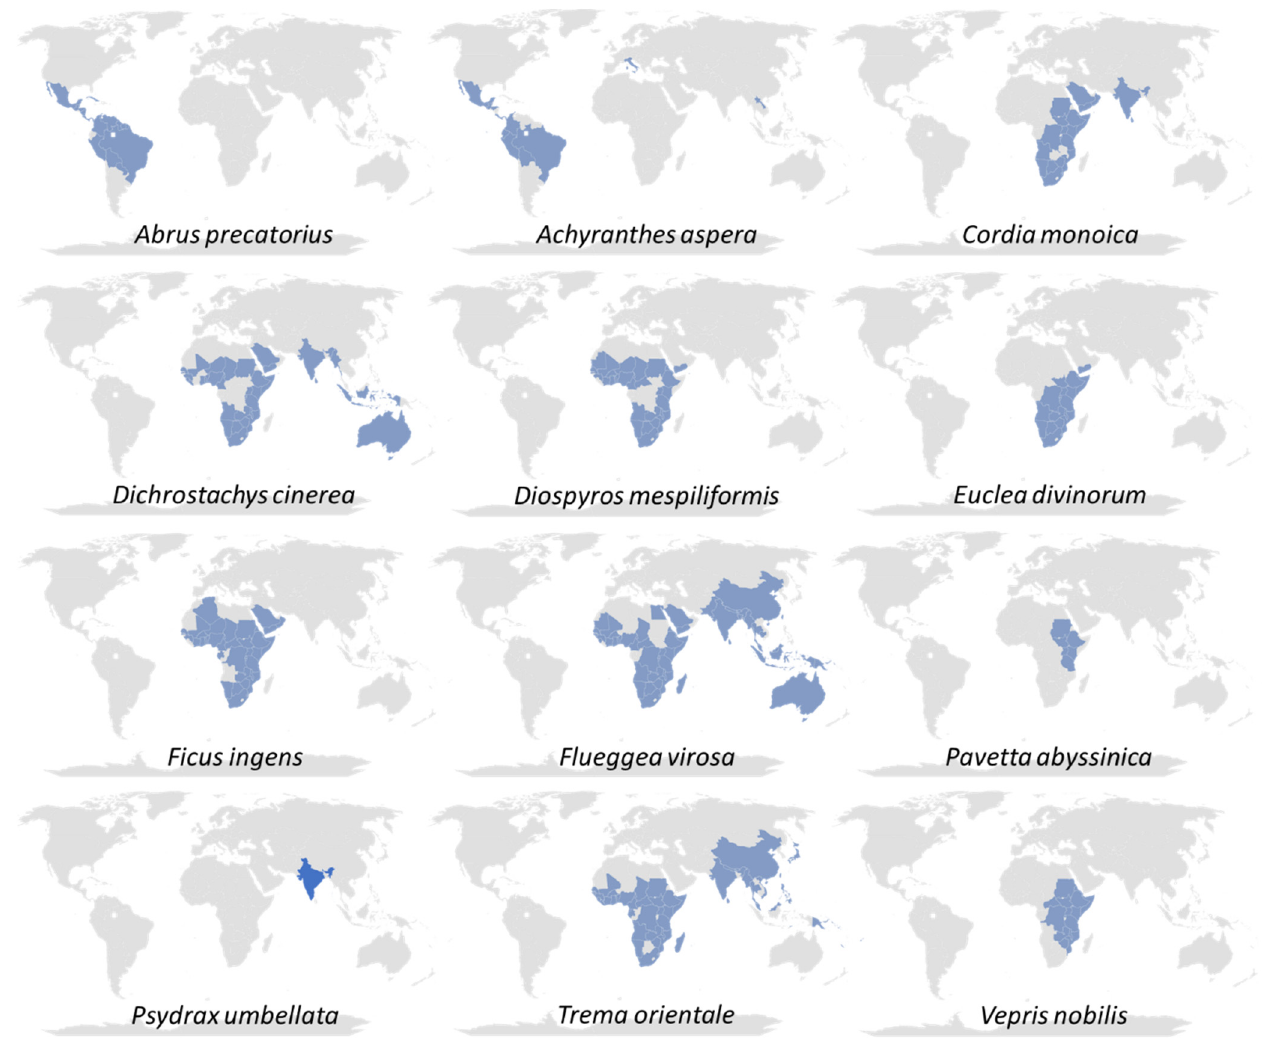
Figure 5. Worldwide distribution of the identified species from the Faifa mountains, Jazan, Saudi Arabia.